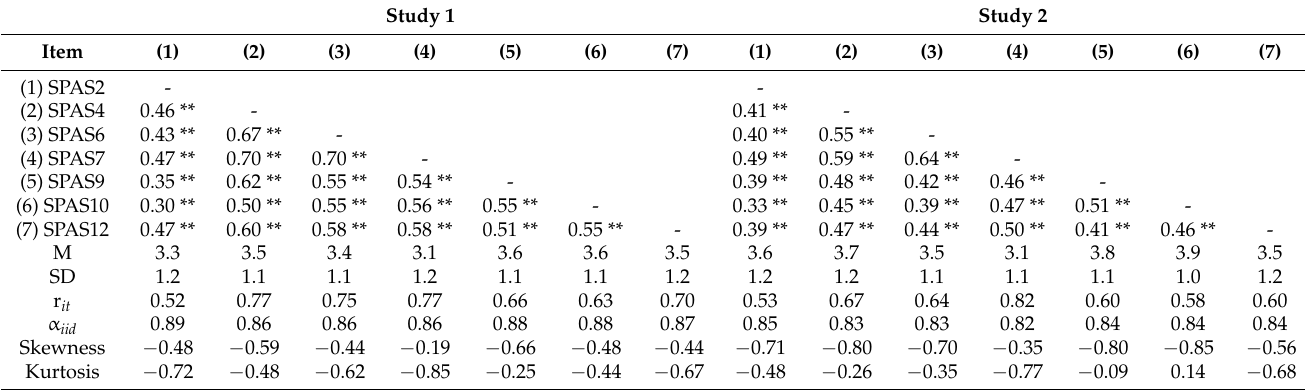
Table 4. Descriptive statistics and correlations for the items of SPAS-7 in Studies 1 and